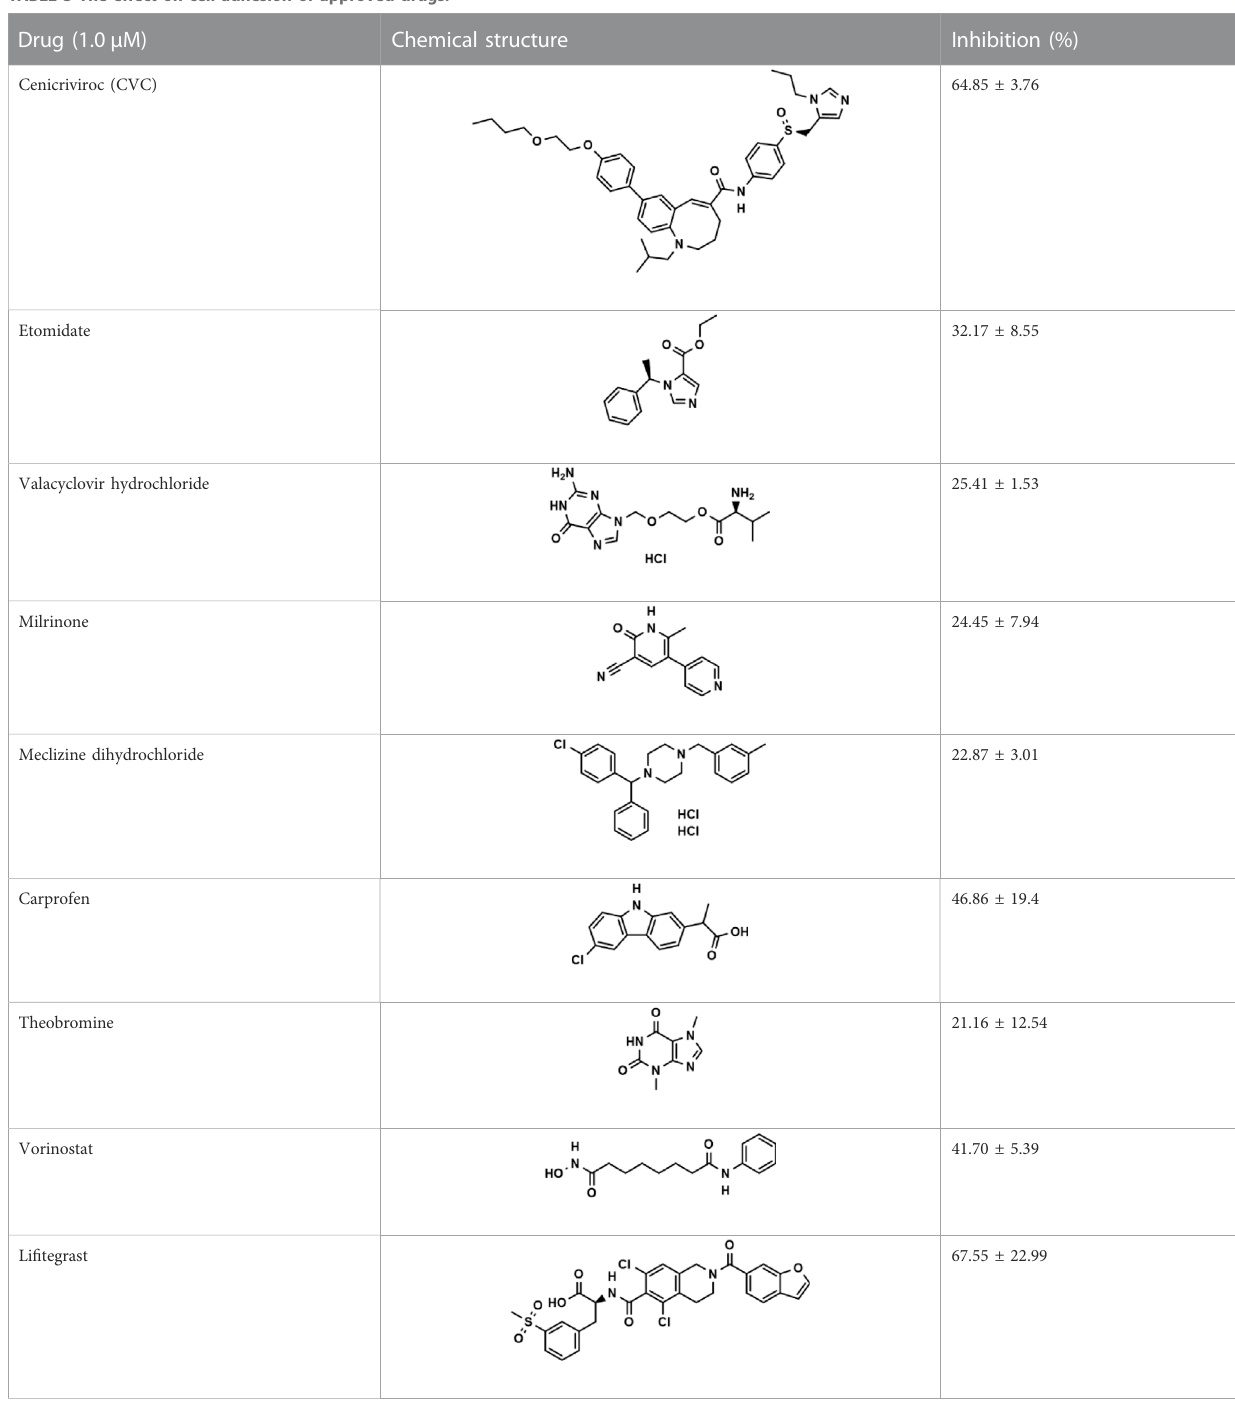
TABLE 3 The effect on cell adhesion of approved